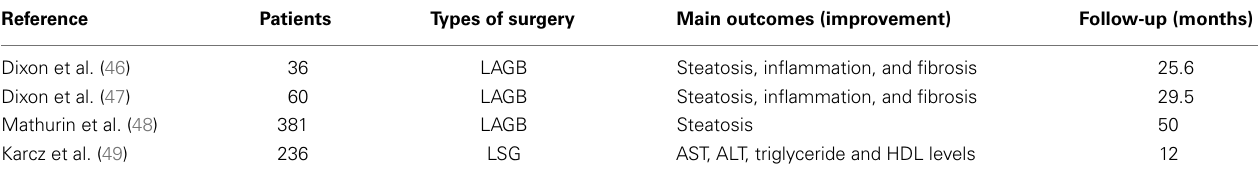
Table 2 | Effect of restrictive bariatric surgery on NAFLD